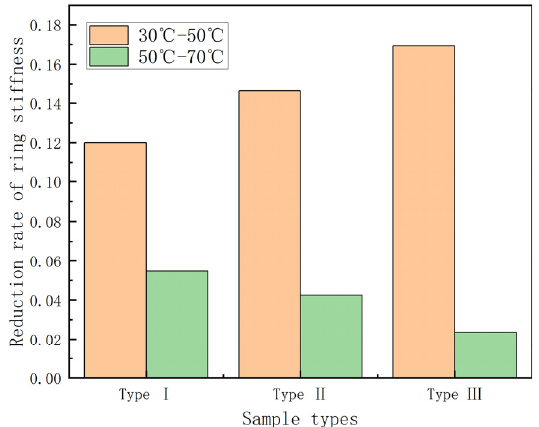
Figure 6. Ring stiffness reduction rate—temperature increment histogram.